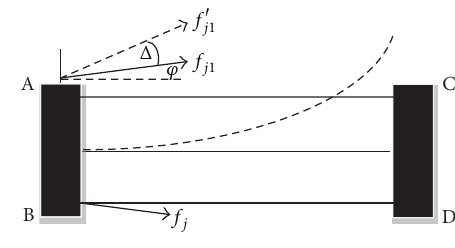
Figure 5: Approximate manipulator workspace.